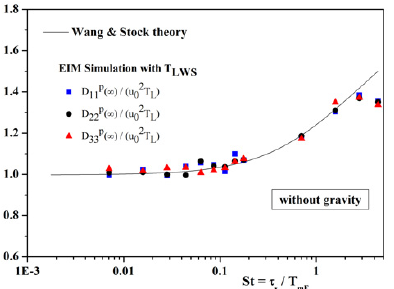
Figure 8. Particle dispersion coefficient (g = 0).